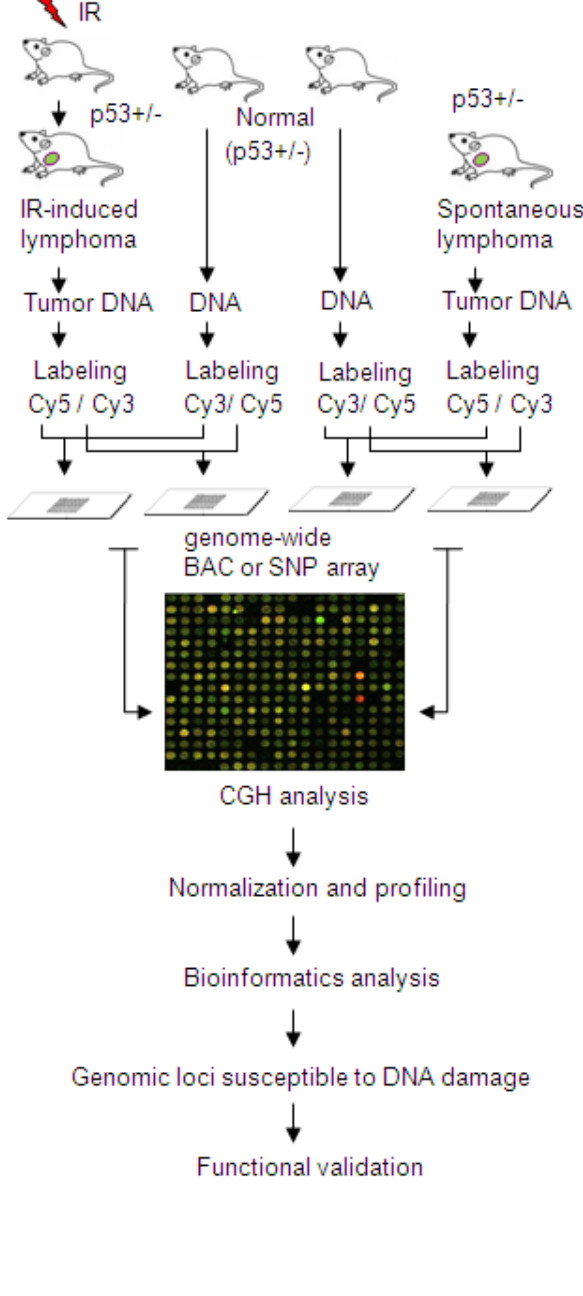
Figure 1. Experimental design for identification of genomic regions susceptible to DNA damage. This approach may be useful to discover evolutionarily conserved CFS genes. IR, ionizing radiation; CGH, comparative genomic hybridization; BAC, bacterial artificial chromosome; SNP, single nucleotide